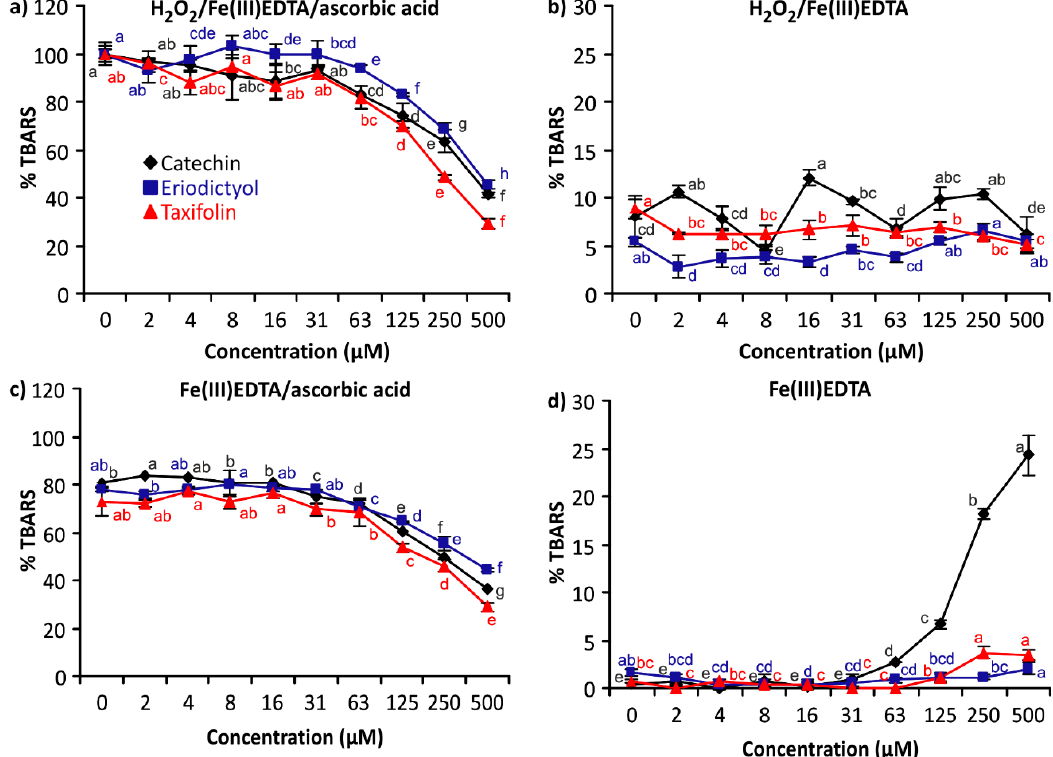
Figure 3. Thiobarbituric acid reactive species (TBARS) production in the reaction mixtures of the deoxyribose degradation assay: ( a ) H 2 O 2 /Fe(III)EDTA/ascorbic acid (1 h incubation);